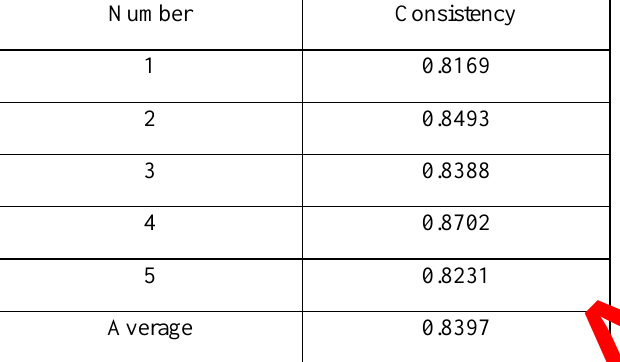
Table 6. Comparison of the average agreement rates of different experimental methods